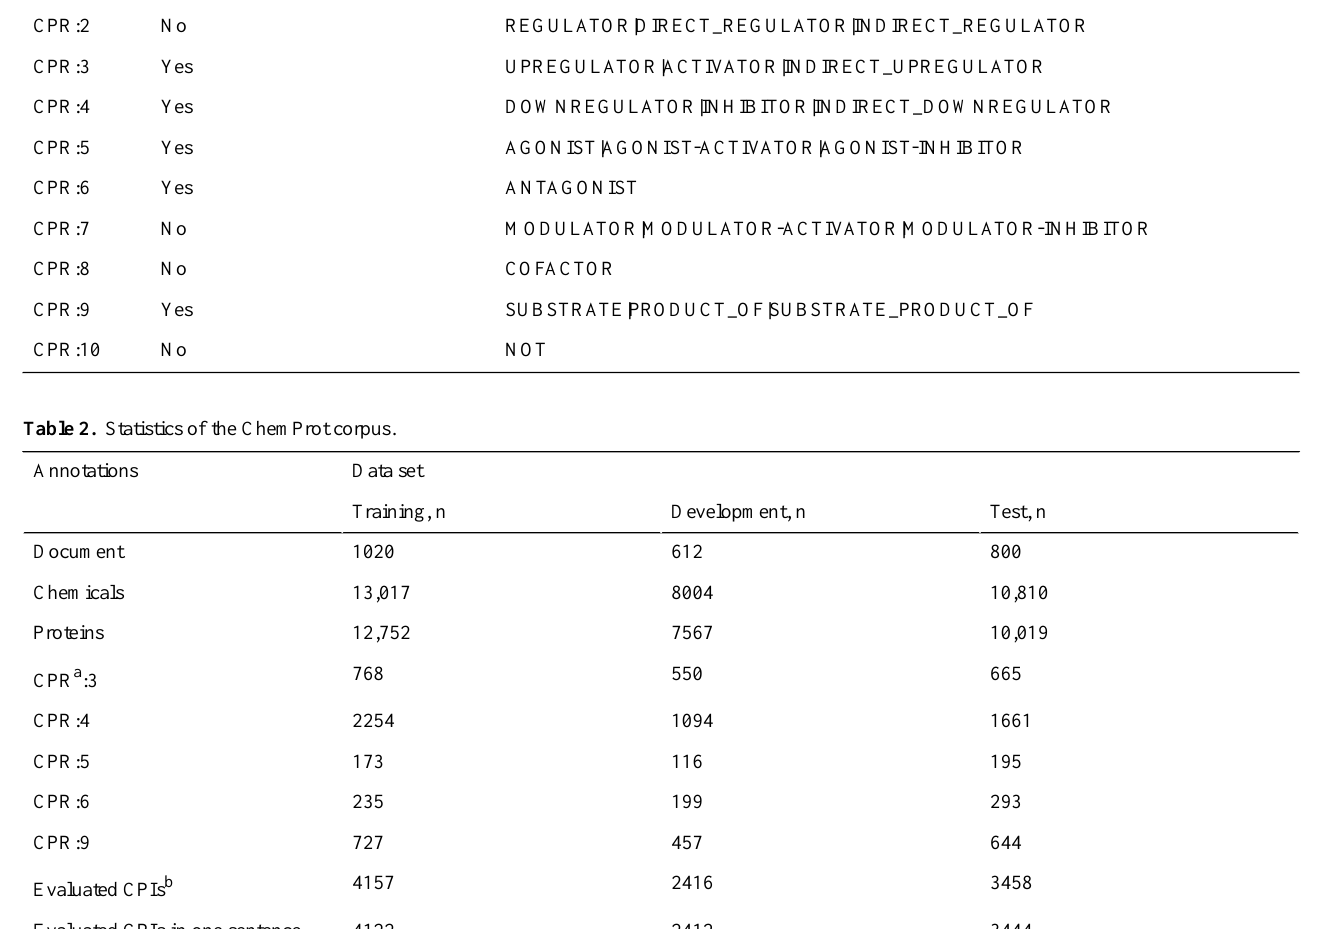
Table 1. The chemical-protein relation (CPR) groups.